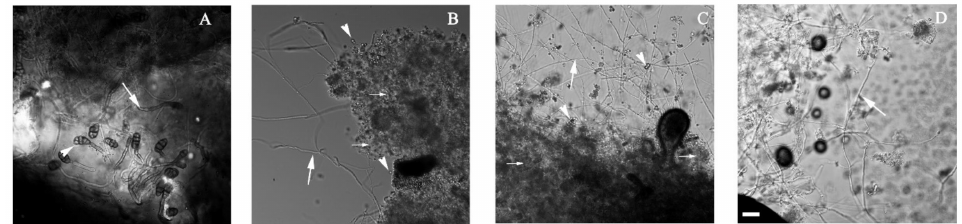
Figure 4. Differential interference contrast microscopy of fungal mycelia grown in Czapek minimal medium containing 0.5% w/v of heavy crude oil (16–20 ◦ API). ( A ) Alternaria sp. conidia (arrowheads) and mycelium (arrows) adhered to the oil after six days of incubation. ( B ) Penicillium sp. 1 hyphae (arrows) and conidia growth (arrowheads) after 24 days of incubation; salts from the Czapek minimal medium (small arrows) can be observed. ( C ) Penicillium sp. 2 mycelium (arrows) and conidia (arrowheads) embedded in salt (small arrows) and petroleum after 24 days of incubation. ( D ) Stemphylium sp. hyphae (arrows) with no attachment to petroleum after 27 days of incubation. Scale bar = 25 µ